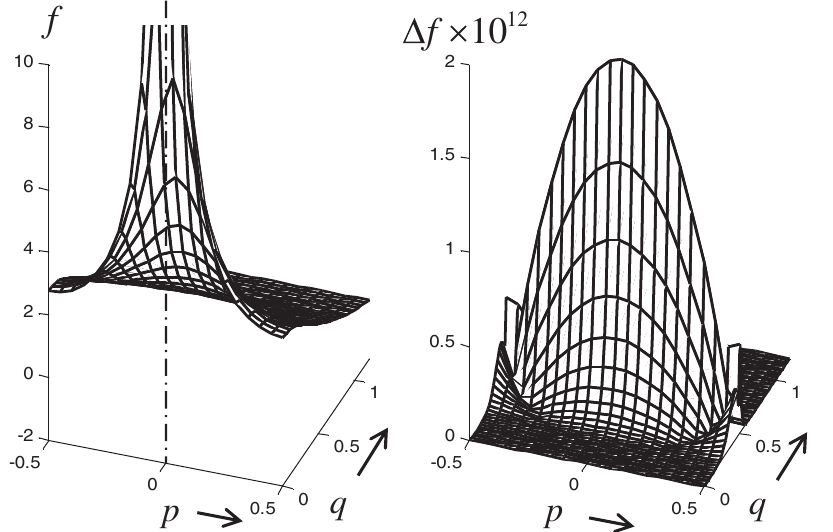
FIG. 4. Function f ð p; q; 0 Þ and absolute error Δ f ð p; q; 0 Þ of the numerical calculation. As f is singular at the origin ( p ¼ q ¼ 0 ), it is truncated for the plot to values below 10. The transition from the Taylor approximation (for small j q j ) to the Fourier series is at j q j ¼ 0 . 5 . The Taylor approximation is used for the upper part of the sum from M 8 terms.